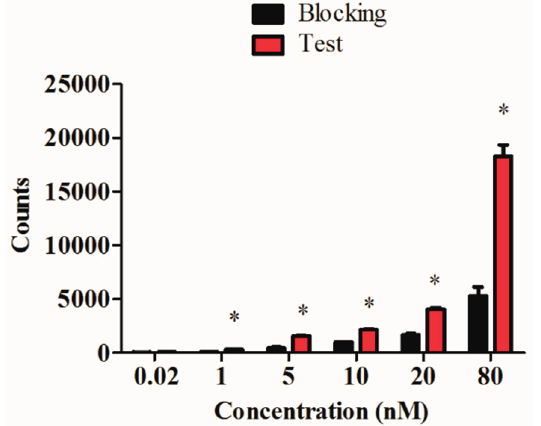
Figure 4. Specific binding of the 99m Tc-RGD4C β L. The 99m Tc-RGD4C β L was